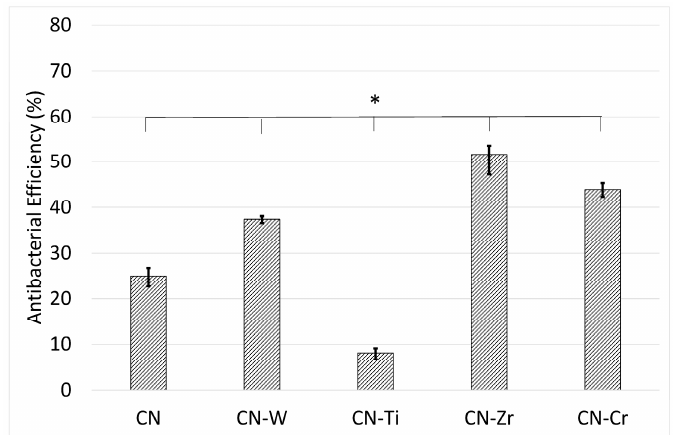
Figure 8. Antibacterial efficiency ( η ) evaluated using Staphylococcus aureus on CNx- and 6 at. % metal-doped CNx-coated SS316L samples, with the uncoated SS316L ones serving as a reference. (*) A value of p < 0.01 was considered to indicate a significant difference between the values of the two groups of samples.